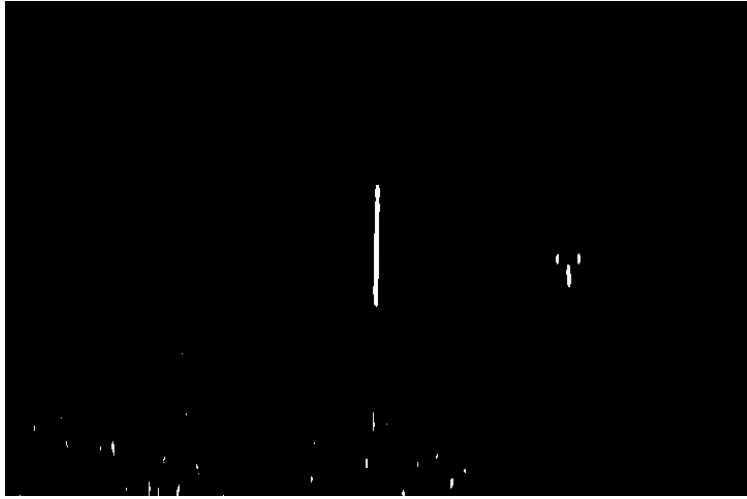
Figure 13. Resultant binary